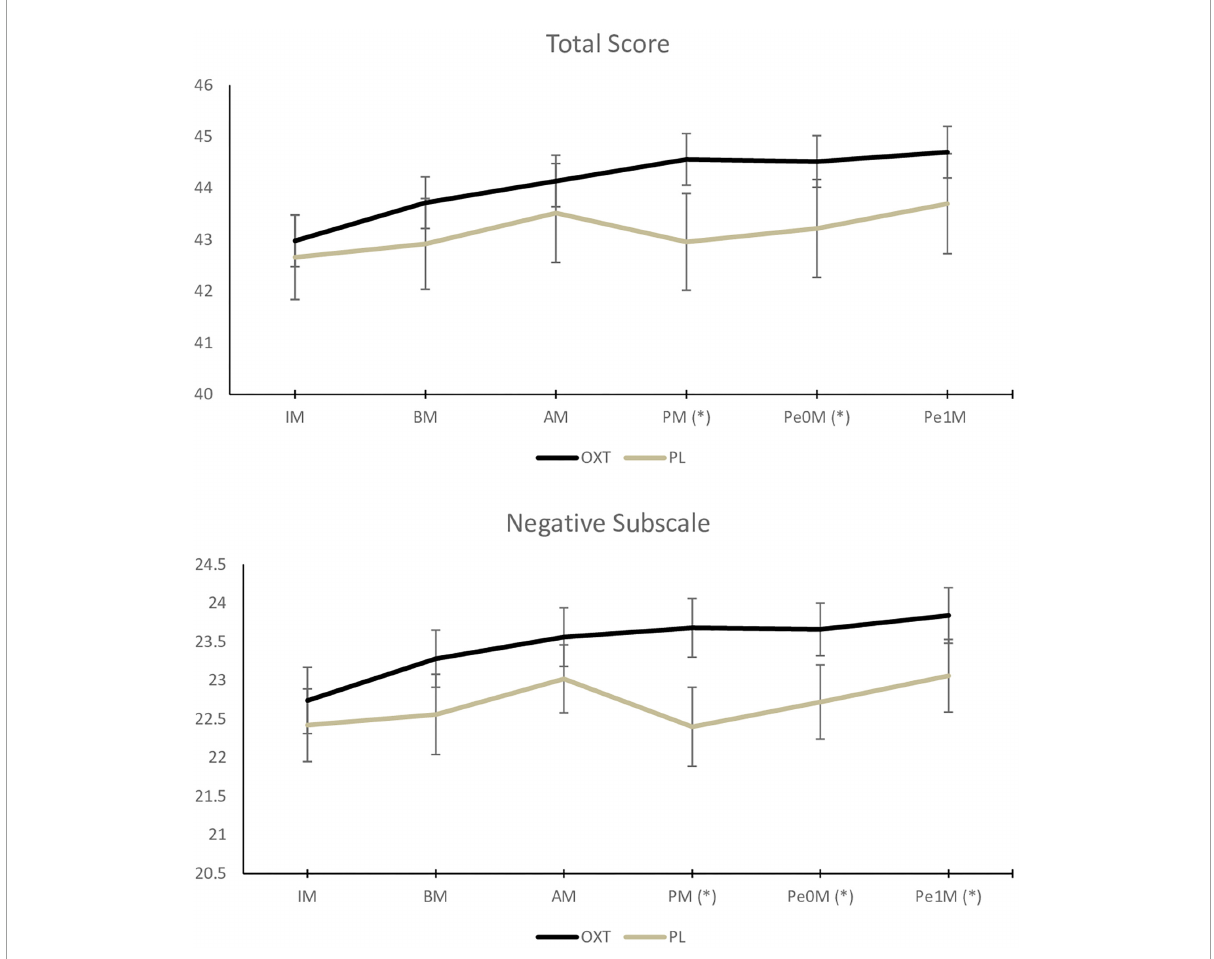
FIGURE2 Effects of oxytocin and placebo on self-perception of performance (Self Statements During Public Performance–state version) (OXT, oxytocin; PLA, placebo; IM, Initial Measure; BM, Baseline Measure; AM, Pre-stress/Anticipation Measure; PM, Execution/Performance Measure; Pe0M, Immediate Post-stress/Recovery Measure; Pe1M, Late Post-stress/Recovery Measure; ∗ difference with statistical significance = p < 0.05; error bar = standard